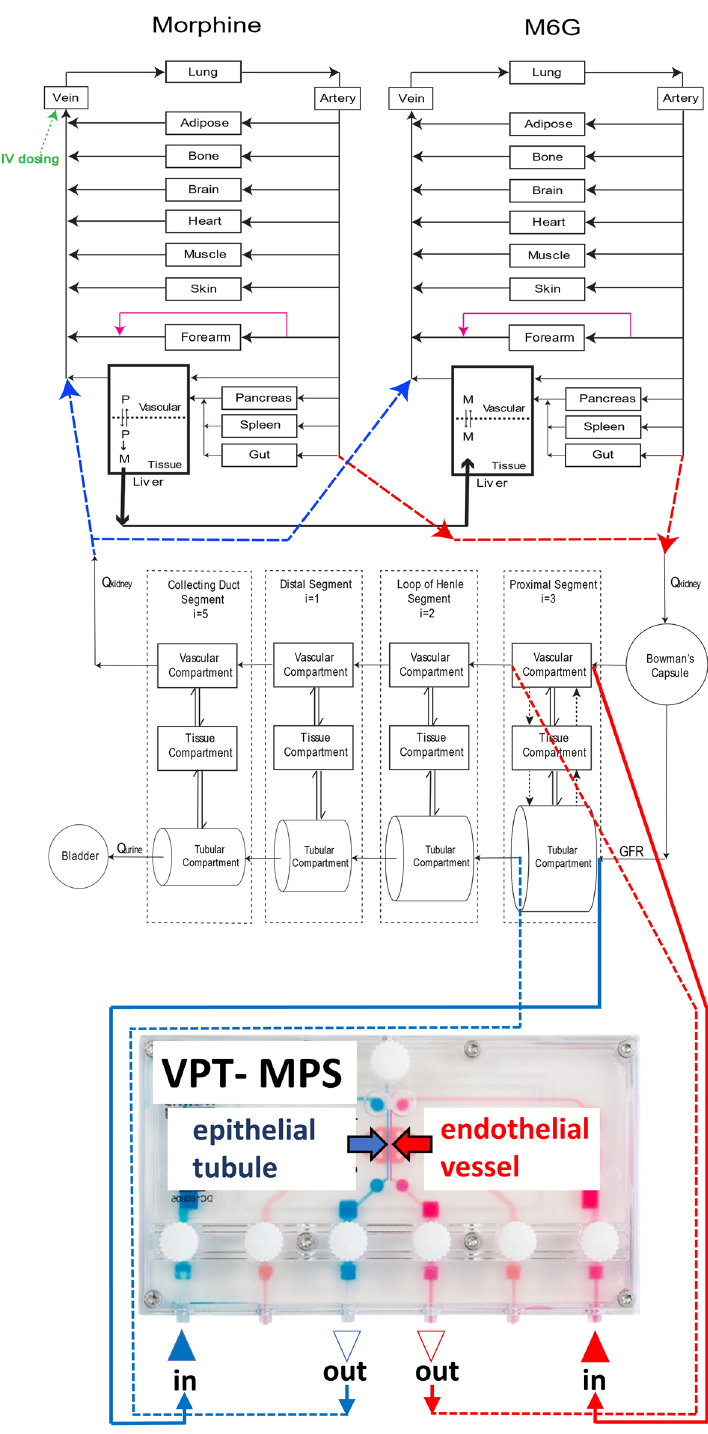
Figure 3. Structure of the mechanistic morphine-M6G parent-metabolite full body PBPK model. Schematic presentation of the physiologically based parent-metabolite pharmacokinetic model that incorporates a mechanistic kidney model, adapted from previous publication 11 . The transporter-mediated active secretion or active reabsorption is shown in black dotted arrows. The bidirectional pH-dependent passive diffusion is shown in double arrows. Lower panel shows VPT-MPS used for evaluation of active transport and passive diffusion of Morphine and M6G, where endothelial vessel and epithelial tubule were shown in red and blue, respectively. Qkidney, kidney blood flow; Qurine, urine formation flow; GFR, glomerular filtration rate; i, the number of subsegments. (Duplo image courtesy of Nortis, Inc., Woodinville,